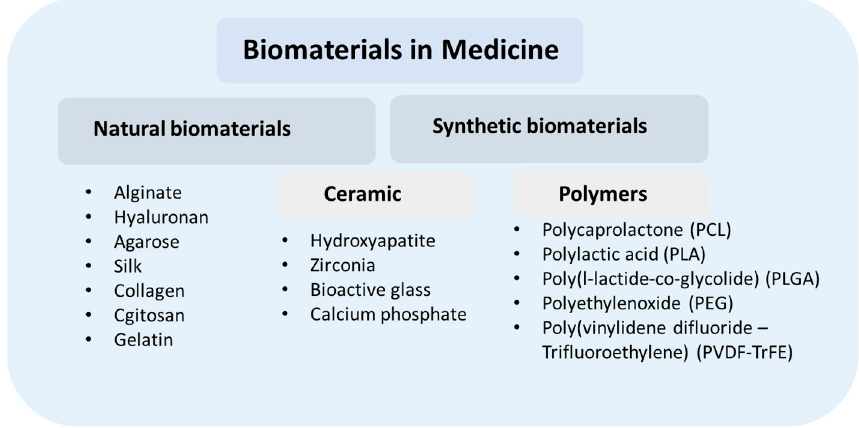
Figure 4. Classification of materials used in medicine.